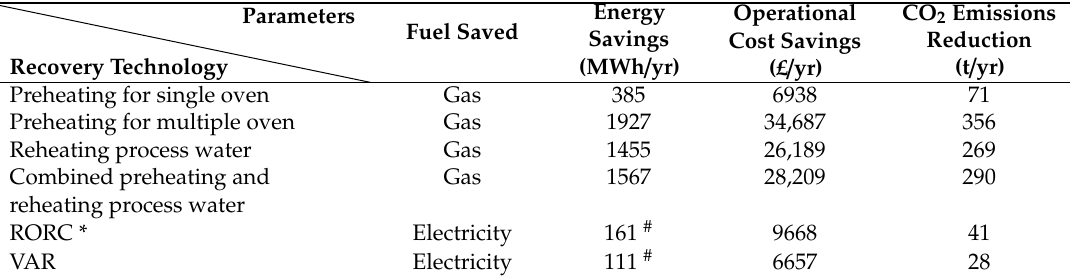
Figure 11. Comparison of heat recovery technologies based on oven’s gas consumption, productivity and effectiveness. Note: the oven productivity values have been multiplied by 10 to fit the graph. Table 15. Annual energy, operational cost and CO 2 savings for the studied heat recovery technologies based on 7000 h of operation per